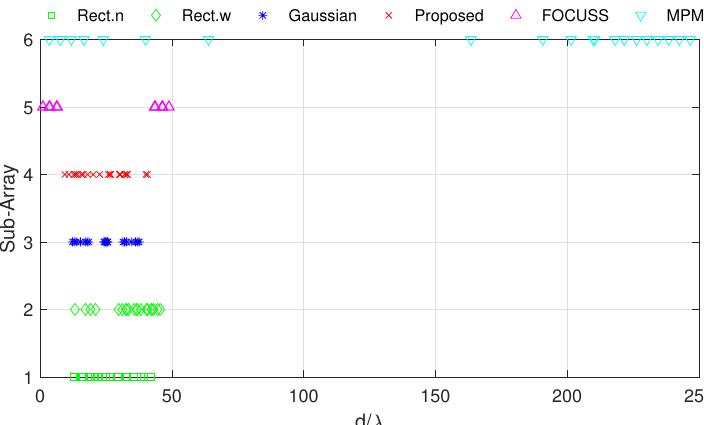
Figure 17. Positions of elements in each subarray generated in Simulation